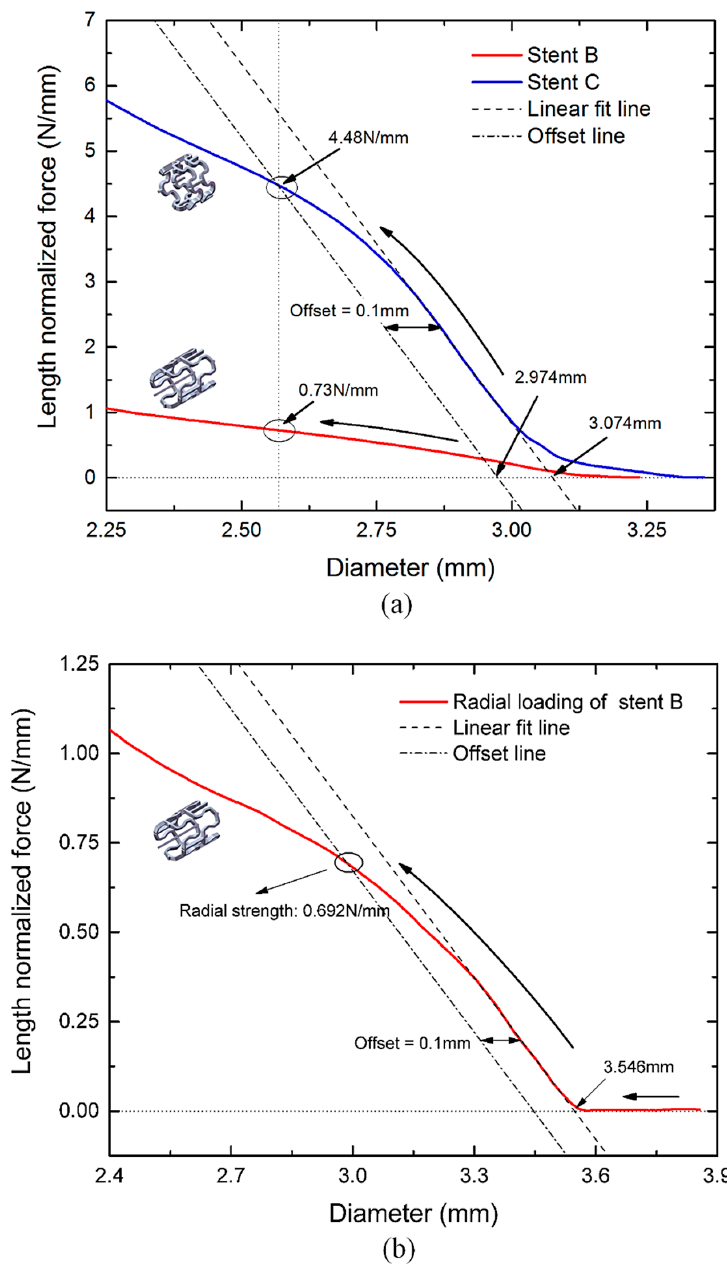
Figure 18. Radial loading curves of Stents B and C after expansion to inside diameters of ( a ) 2.5 and ( b ) 3.0 mm.